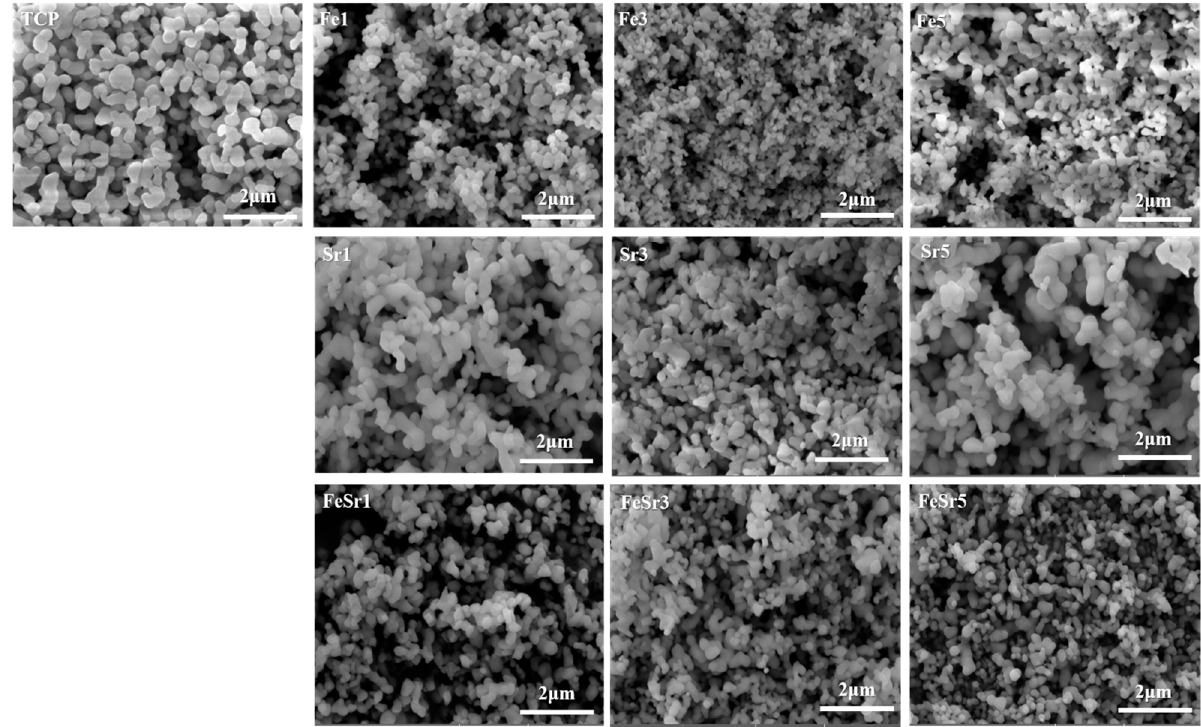
Figure 4. SEM images of various β -TCP powders annealed at 800 °C .